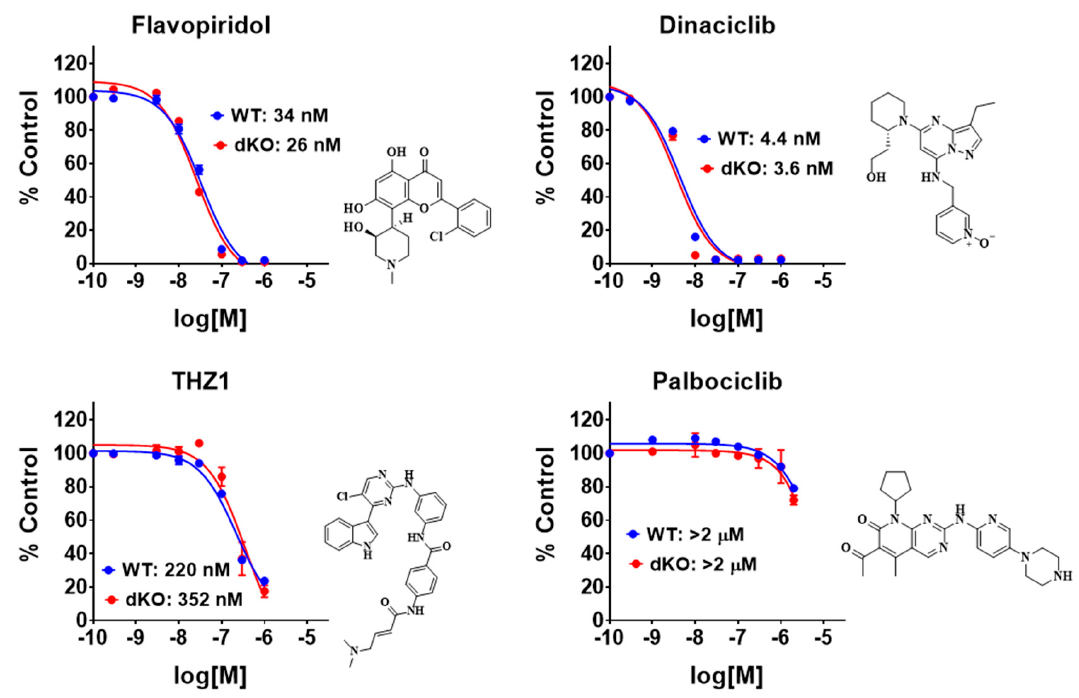
Figure 3. E ff ects of flavopiridol, dinaciclib, THZ1 and palbociclib at di ff erent concentrations on the Figure 3. Effects of flavopiridol, dinaciclib, THZ1 and palbociclib at different concentrations on the induced NF κ B reporter activity in WT and dKO 293 cells treated with 10 ng / mL TNF α for 3 induced NF κ B reporter activity in WT and dKO 293 cells treated with 10 ng/mL TNF α for 3 h.